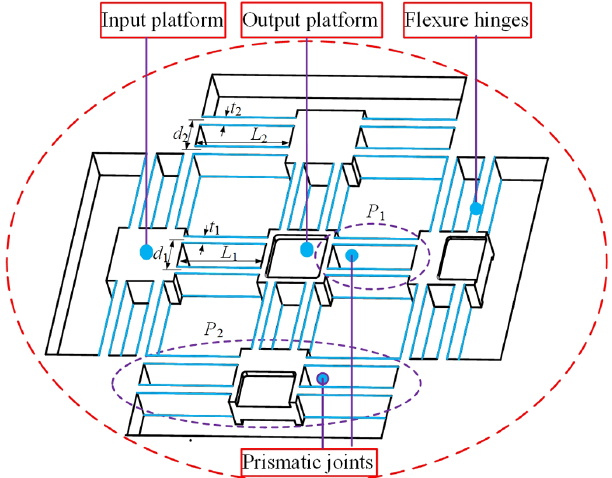
Figure 1. The detailed structure of the flexure-based stage.